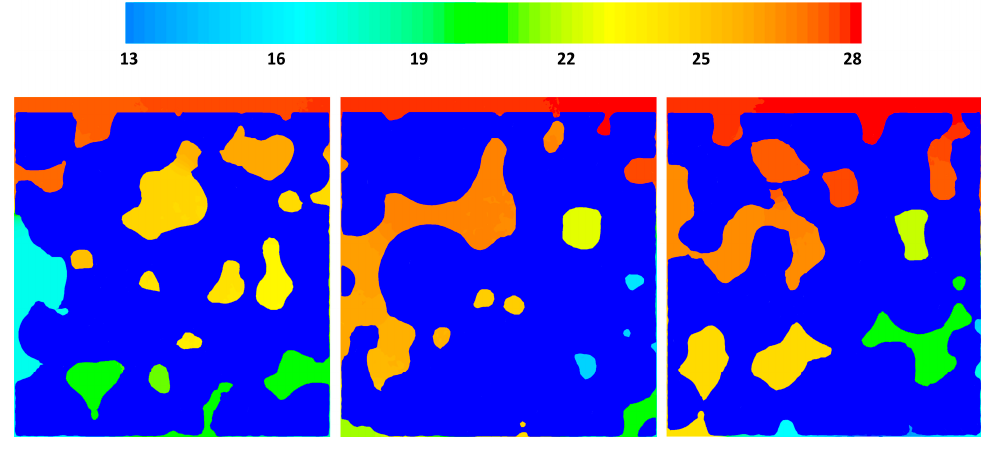
Figure 5. Relative pressure (P abs − 101,300) gradients on cross-sectional planes x = − 1.5, x = 0 and x = 1.5.